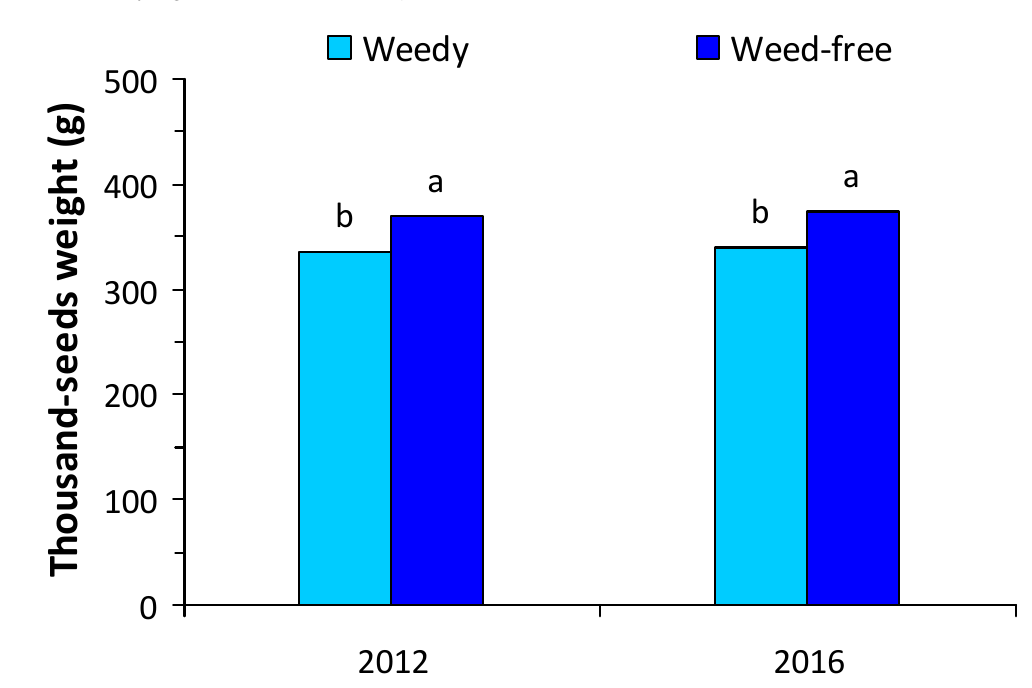
Figure 3. Thousand-seeds weight of white lupine in weedy and weed-free treatments in the first and second growing seasons. Different letters in each growing season indicate statistically significant differences at p < 0.05.